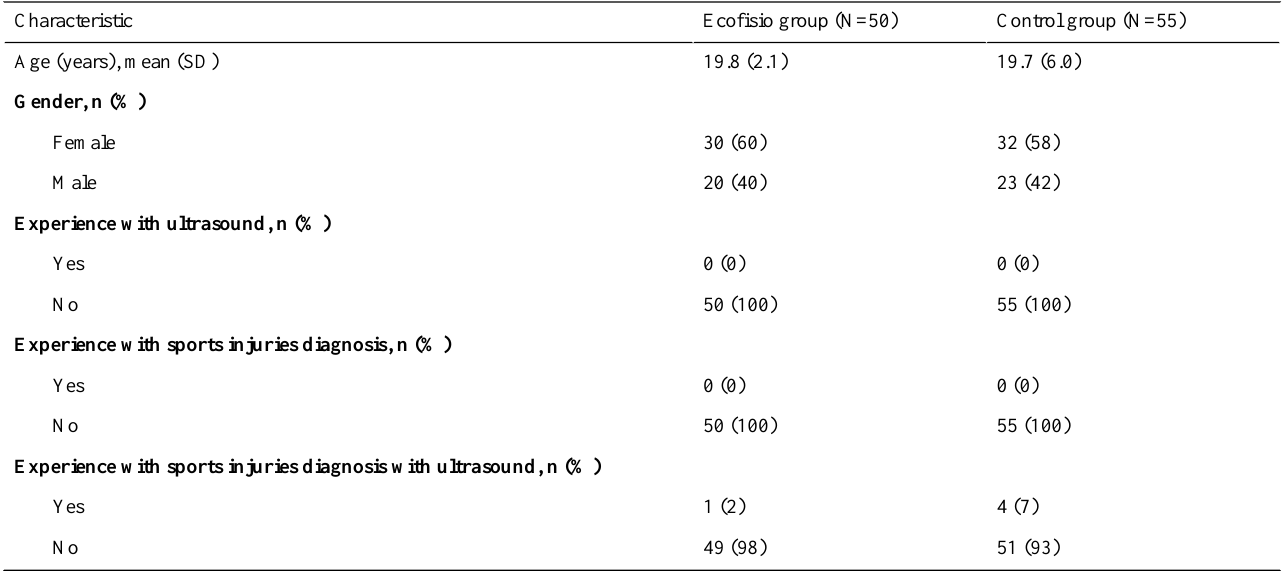
Table 1. Characteristics of groups.